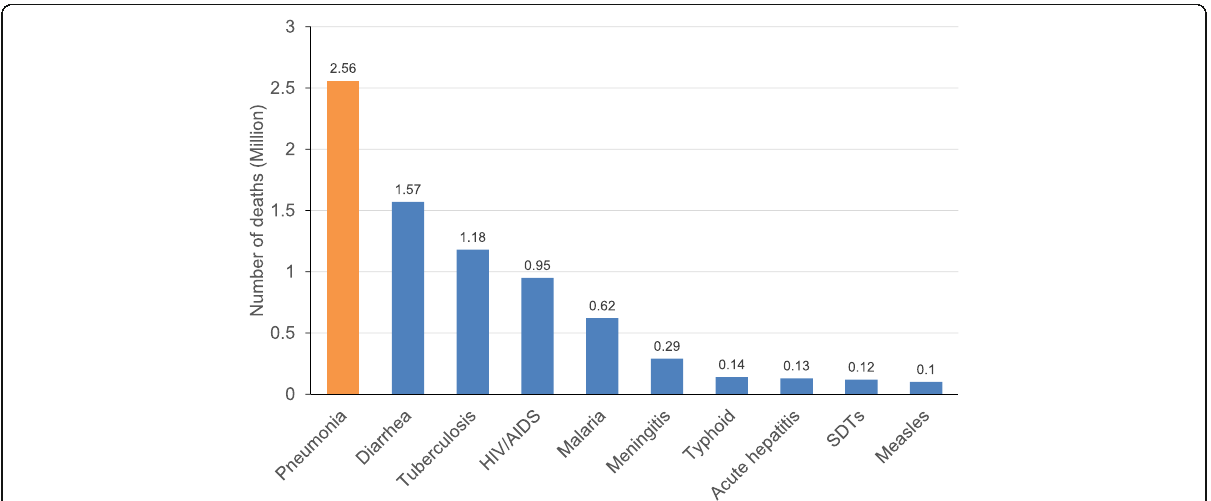
Fig. 2 Pneumonia is the leading infectious cause of death in the world (source Global Burden of Disease,